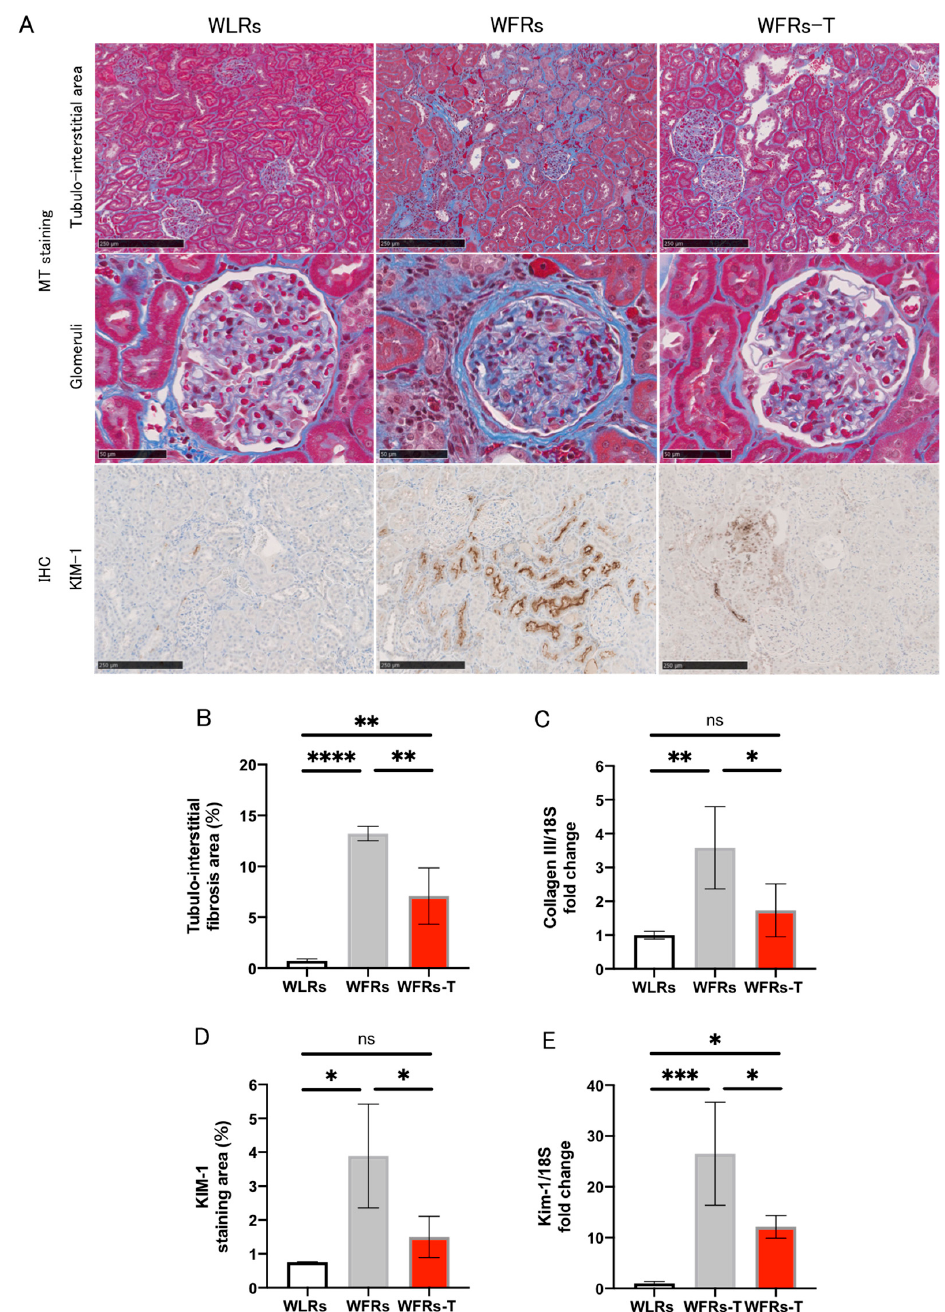
Figure 2. Changes in renal fibrosis and tubular cell damage: ( A ) representative images of MT (Masson’s trichrome) staining in the tubulointerstitial area (scale bar: 250 µ m) and glomeruli (scale bar: 50 µ m) as well as immunohistochemistry (IHC) of KIM-1 in the tubulointerstitial area (scale bar: 250 µ m); ( B ) quantification of tubulointerstitial fibrosis area ( n = 4); ( C ) mRNA expression of collagen III, normalized according to 18S levels in the renal cortex ( n = 5); ( D ) quantification of KIM-1 staining area ( n = 3); and ( E ) mRNA expression of Kim-1, normalized according to 18S levels in the cortex ( n = 3–4). All data are means ± standard deviation (SD). * p < 0.05, ** p < 0.01, *** p < 0.001, **** p < 0.0001, ns: not significant. KIM-1 and Kim-1, kidney injury molecule-1; WLRs, sedentary Wistar lean rats; WFRs, sedentary Wistar fatty rats; WFRs-T: Wistar fatty rats with treadmill exercise